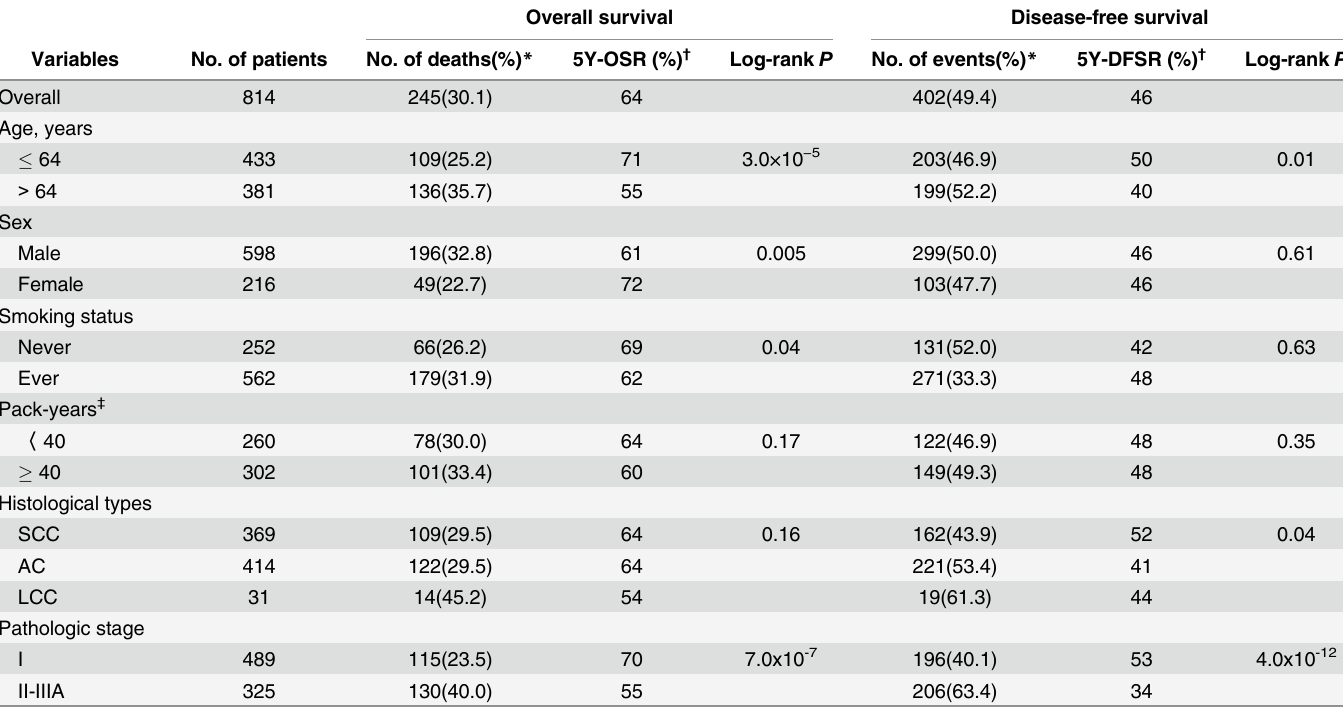
Table 1. Univariate analysis for overall survival and disease-free survival by clinicopathologic features. Overall survival Disease-free